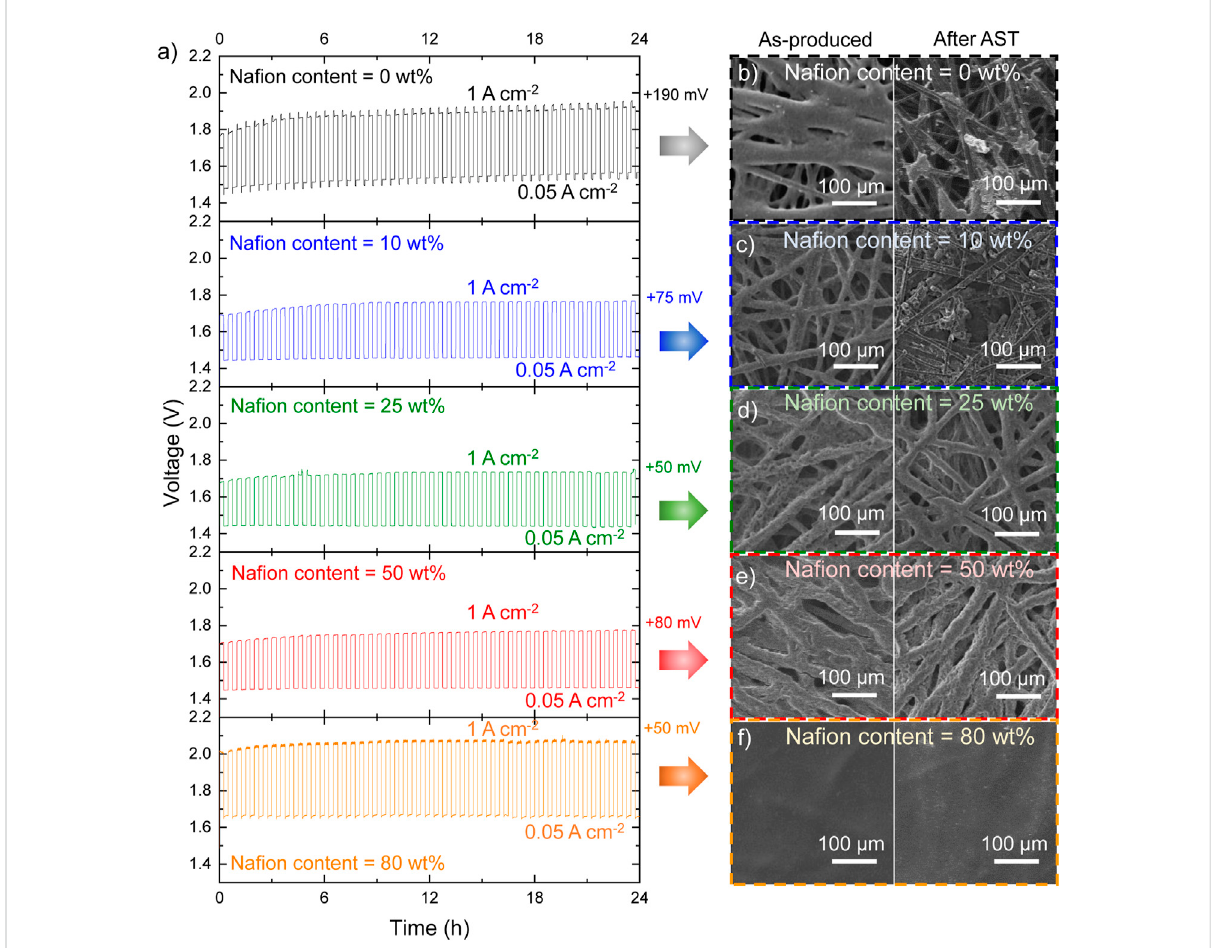
FIGURE 3 (A) AST tests for the Pt/C || SSM AELs based on Pt/C cathodes (m Pt ~300 μ g cm − 2 ) produced with different Na fi on contents in the catalyst layer. Thevoltageincreaseat1 Acm − 2 aftertheASTisalsoindicatedforeachAEL. (B – F) SEMimagesofrepresentativesurfaceregionsofthePt/Ccathodes before and after the ASTs of the corresponding